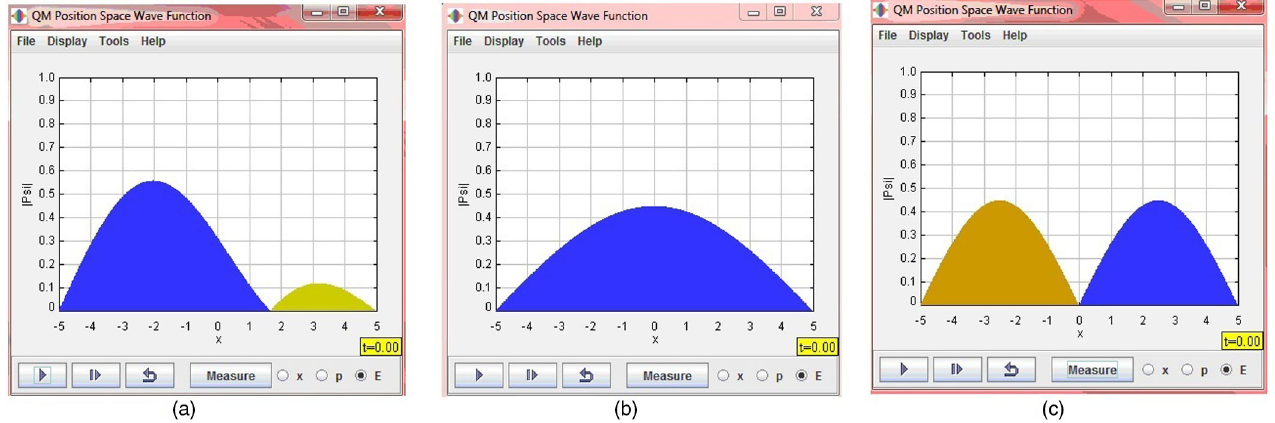
FIG. 2 (color online). Simulation program of the energy measurement on a superposition state [as shown in (a)] with two energy eigenstate components [as shown in (b) and (c)]. The vertical axis is the absolute value of the wave function (not the probability density for position measurement) and the horizontal axis is the position x .